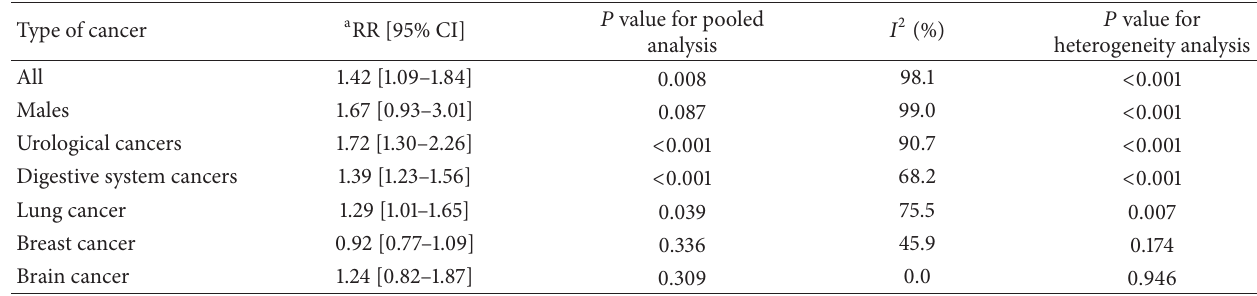
Table 2: Summary of meta-analysis